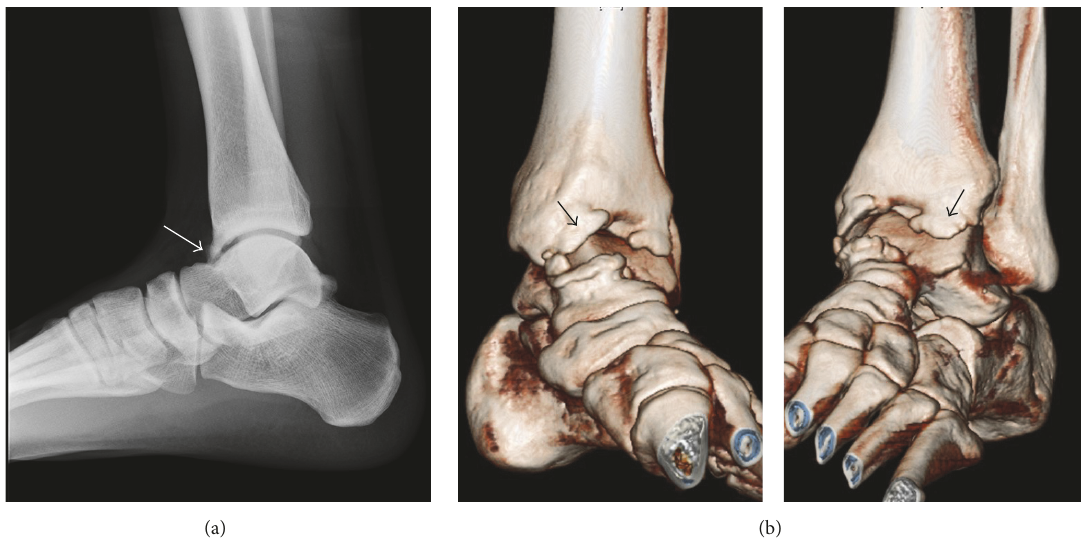
Figure 1: (a) Plain radiograph and (b) three-dimensional computed tomography scan acquired at initial consultation indicating osteophytes at the anterior edge of the distal tibial end and the dorsal side of the talar neck ((a) white arrow, (b) black arrow).